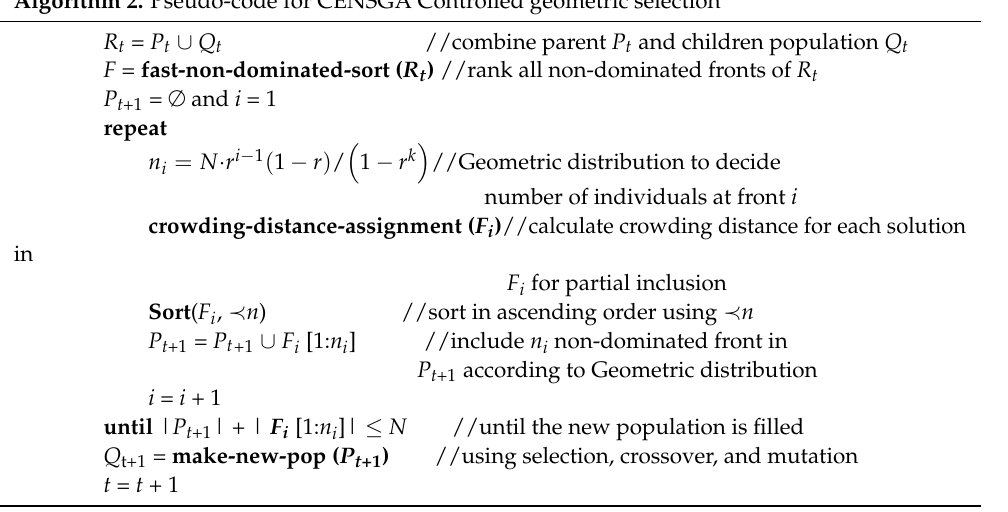
Algorithm 2. Pseudo-code for CENSGA Controlled geometric